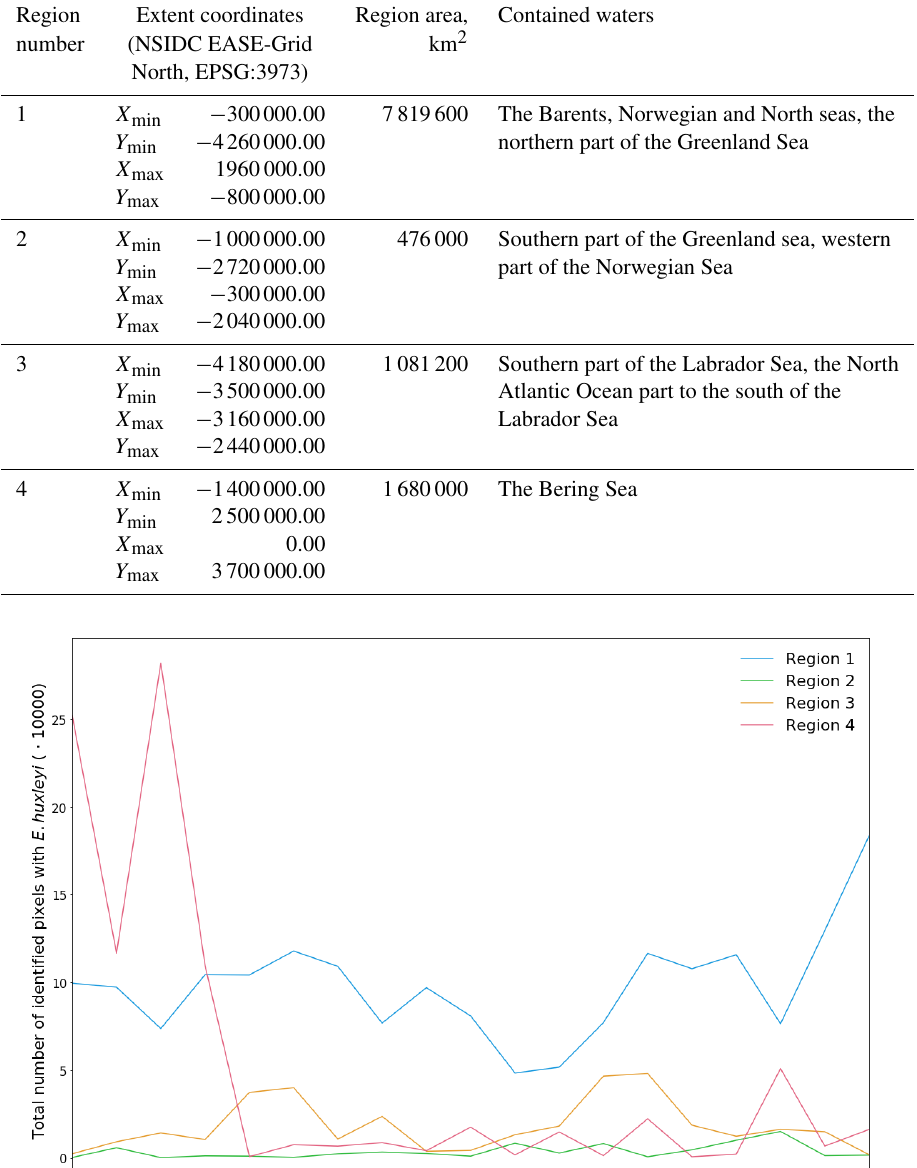
Table 1. Description of spatial regions.